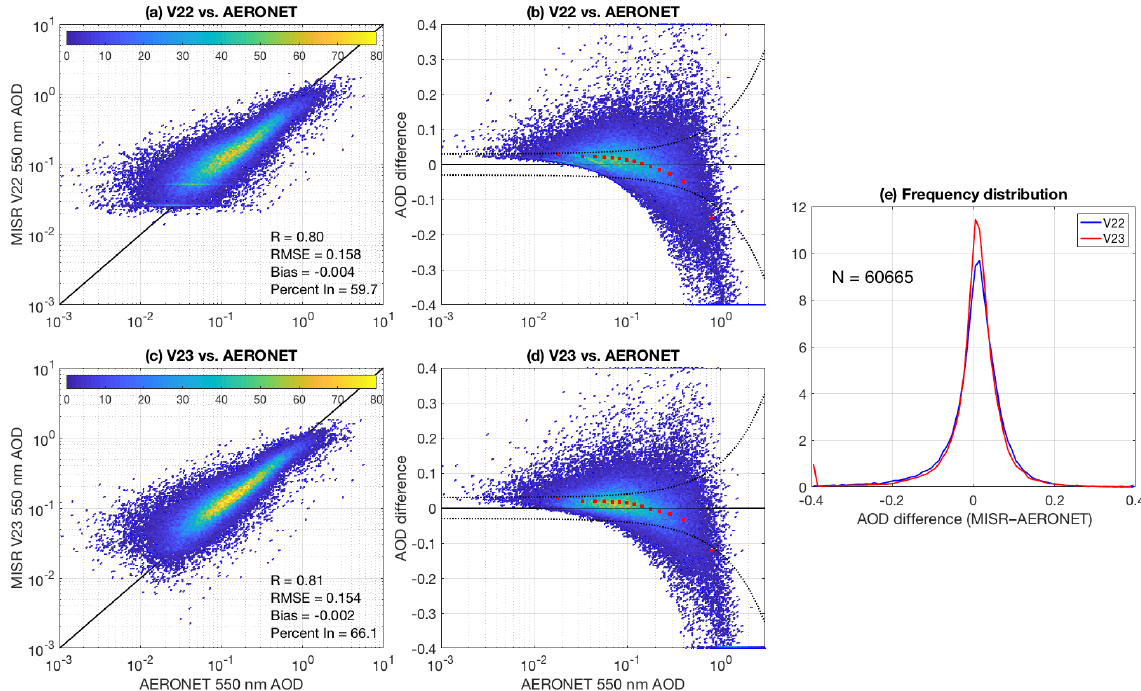
Figure 15. MISR V22 and V23 retrieval comparisons against AERONET observations: (a) density plot of MISR V22–AERONET collo- cations including overall statistics, (b) density plot of AOD difference (MISR V22–AERONET) as a function of AERONET AOD, points outside of the y axis limits are grouped on the edges, red squares denote the median values for data split into 14 equally populated bins, and the dotted black lines mark the EE of ± ( 0 . 03 + 10%). (c) is similar to (a) but for MISR V23–AERONET collocations. Panel (d) is similar to (b) but for MISR V23 retrievals. (e) Histograms of the MISR–AERONET AOD difference for V22 (blue line) and V23 (red line) retrievals. The number of joint V22–V23–AERONET collocations is 60665.